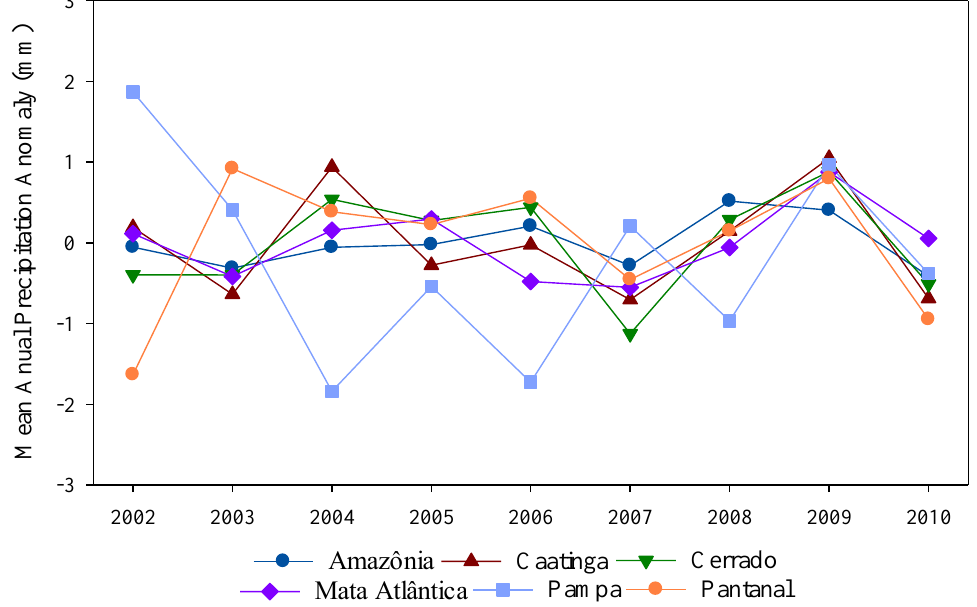
Figure 7. Annual mean precipitation anomalies (2002 to 2010) in the Brazilian